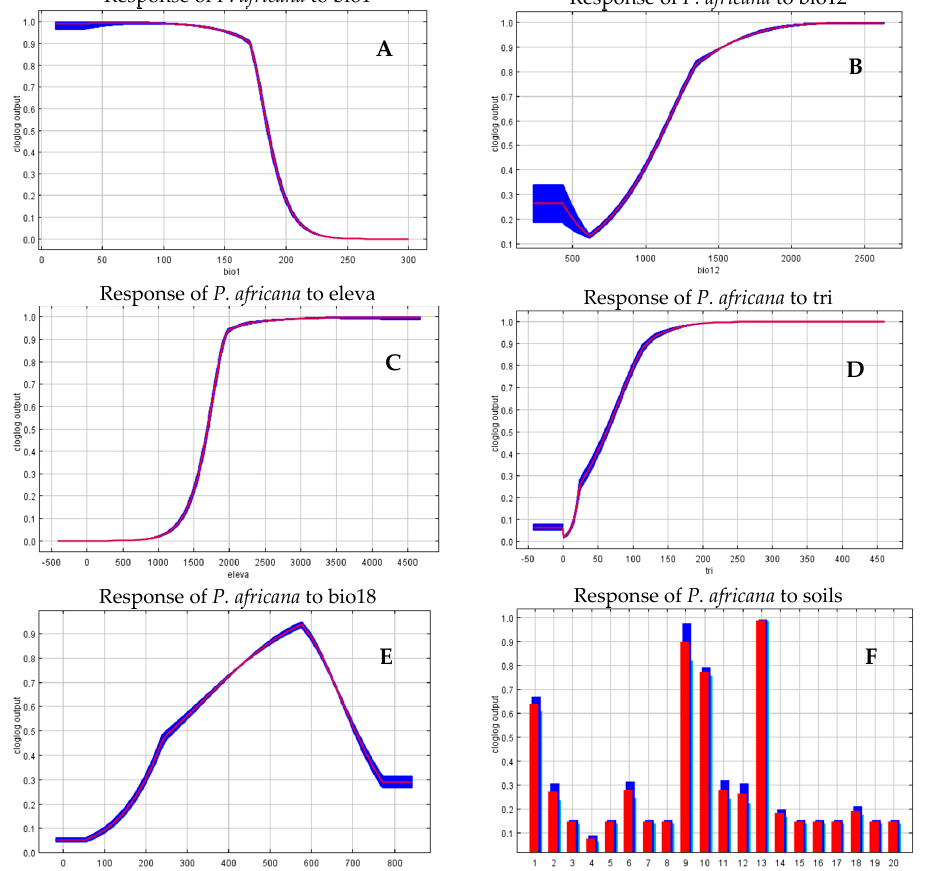
Figure 3. Relationships between selected environmental variables and probability of species suitability of P. africana ( A ) mean annual temperature (bio1) ( B ) annual precipitation (bio12), ( C ) elevation (eleva), ( D ) terrain ruggedness index (tri), ( E ) precipitation of warmest quarter (bio18), ( F ) soil types (soils). The y-axis represents the probability of presence (cloglog output). Red curves show the average response and blue margins are ± SD calculated by 30 replicate runs. For the interpretation of soil type legend, refer Table 1.